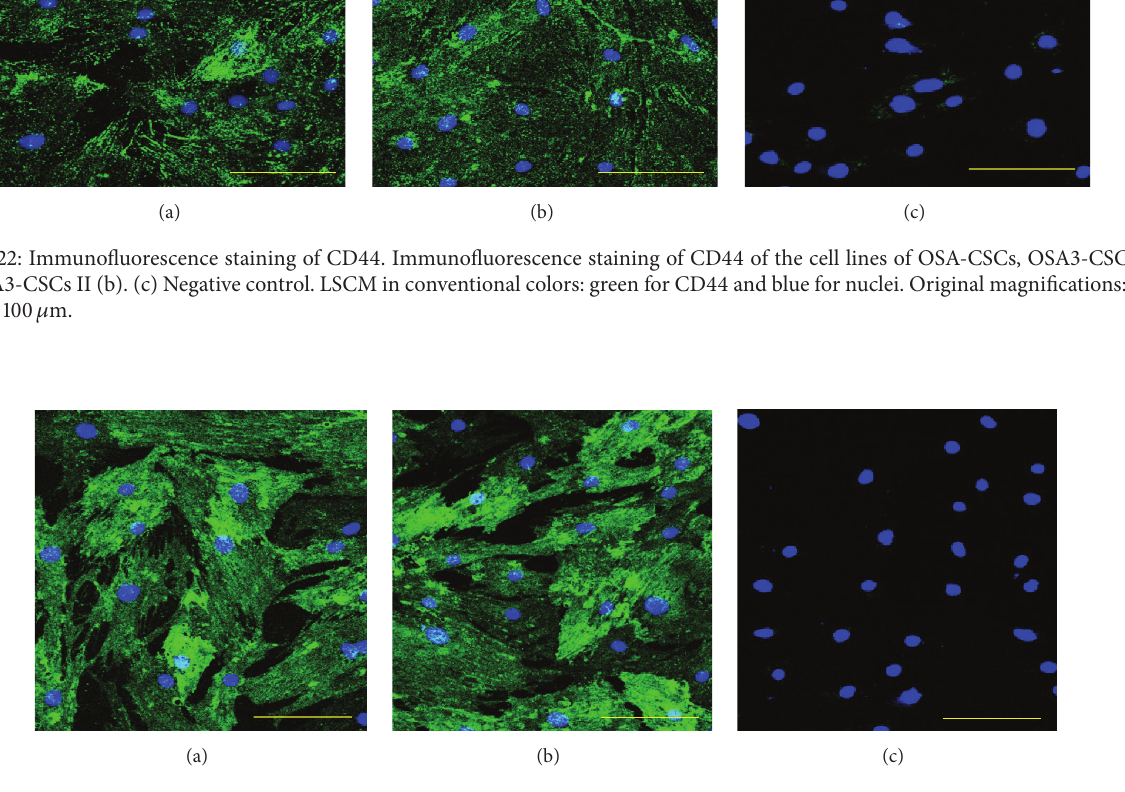
Figure 23: Immunofluorescence staining of CD105. Immunofluorescence staining of CD105 of the cell lines of OSA-CSCs, OSA3-CSCs (a) and OSA3-CSCs II (b). (c) Negative control. LSCM in conventional colors: green for CD105 and blue for nuclei. Original magnifications: 20x. Bar size: 100 𝜇 m.